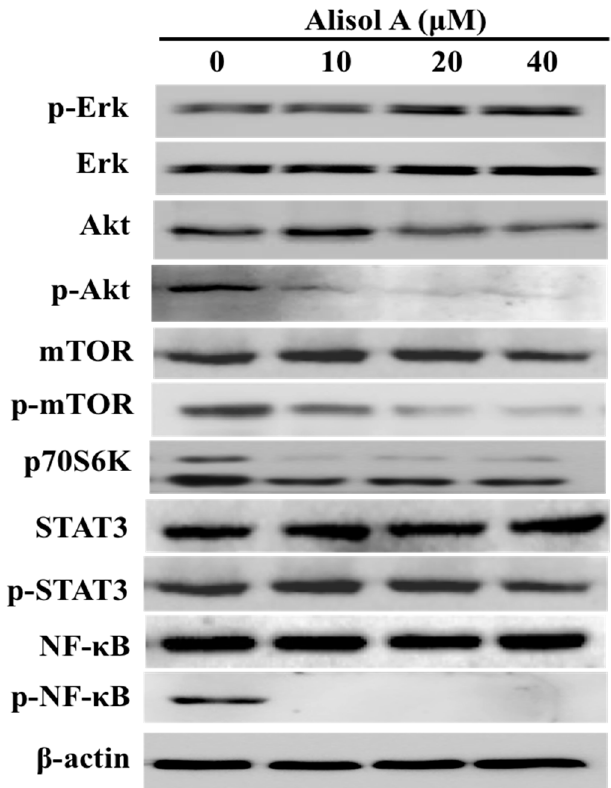
Figure 6. Effects of alisol A on autophagy related signaling pathways. The cells were treated with alisol A for 24 h. The cell lysates were collected and subjected to Western blotting analysis to detect the expression of proteins in cancer cells. Results are representative of at least three independent experiments showing similar results.